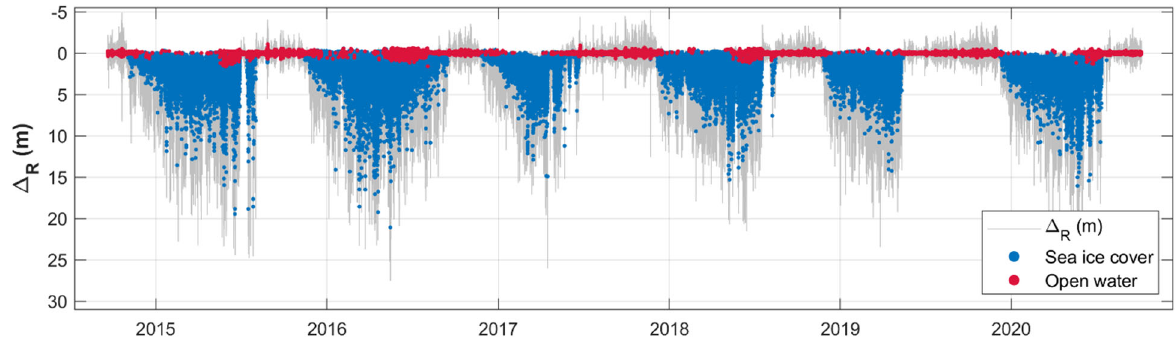
Figure 9. Plot of ∆ R with the SOM analysis. The full-resolution time series of ∆ R from the AZFP in the NE Chukchi Sea is plotted in gray, with each 15-min period ∆ R mean marked as Mode 1 (open water; red) or Mode 2 (ice cover; blue) according to the SOM. Note the existence of many open water ensembles in the presence of ice cover, representing sound speed correction tie points.